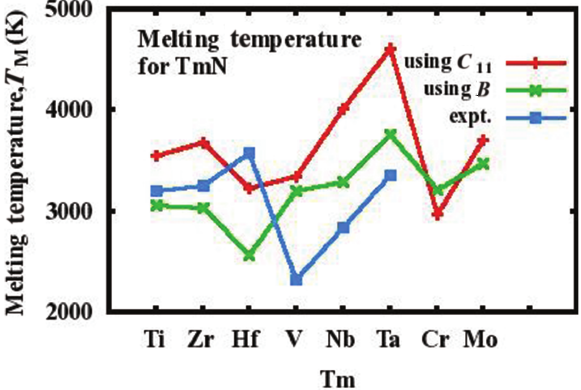
Figure 11: Estimated and experimental melting temperatures of